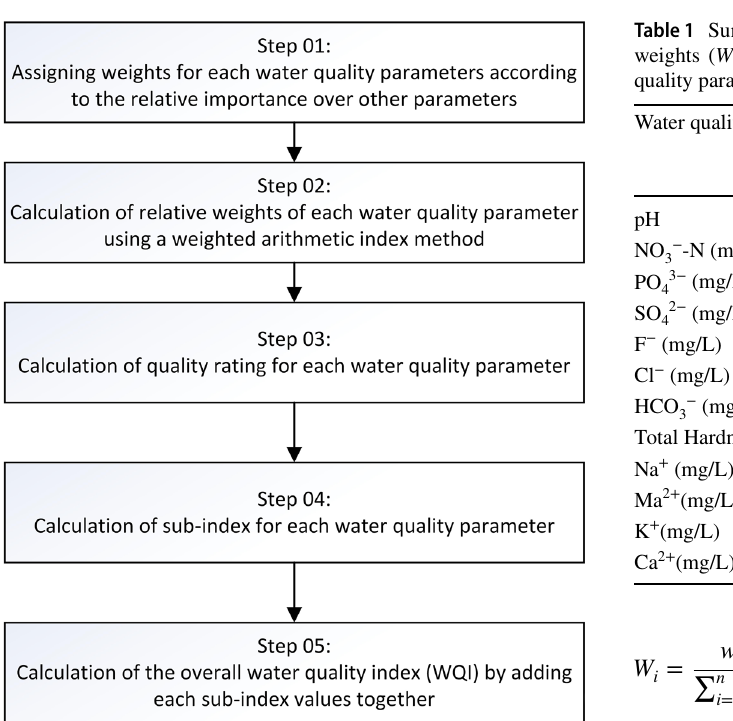
Fig. 3 Flow chart showing the five steps followed to calculate the WQI